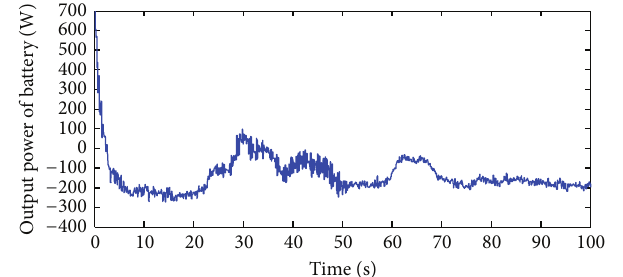
Figure 13: The output power of the super capacitor.